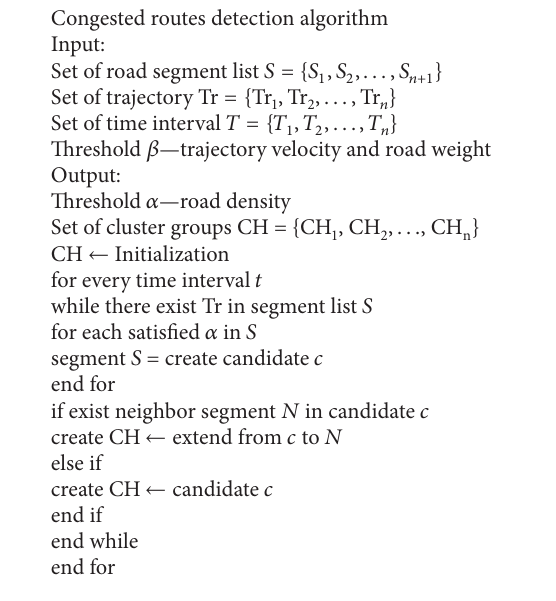
Algorithm 1: The algorithm of the proposed scheme.